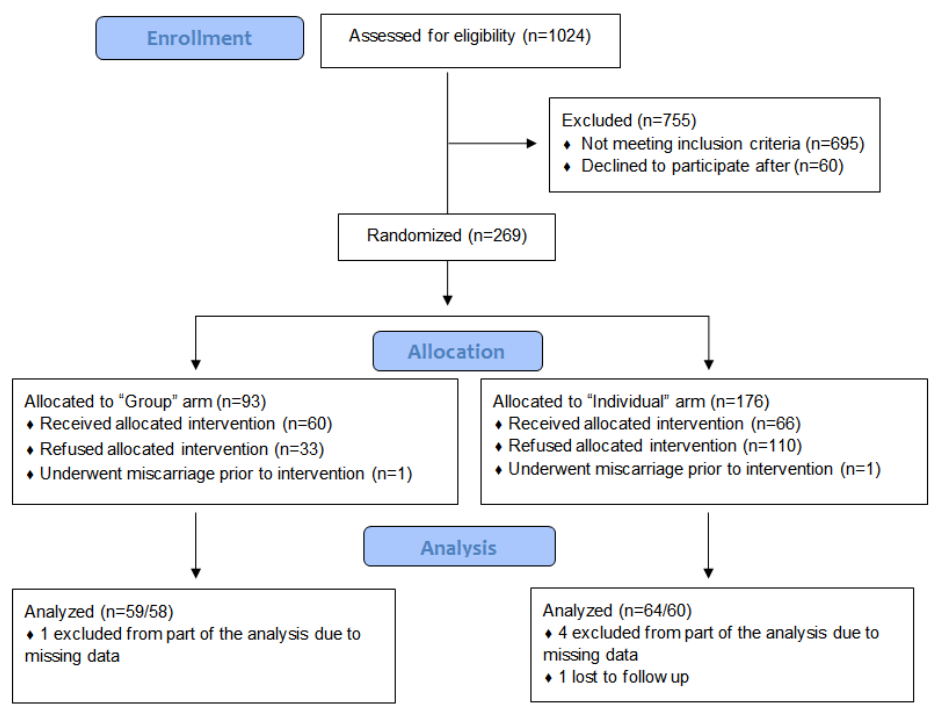
Figure 1. Flowchart of the study cohort showing inclusion and exclusion criteria .